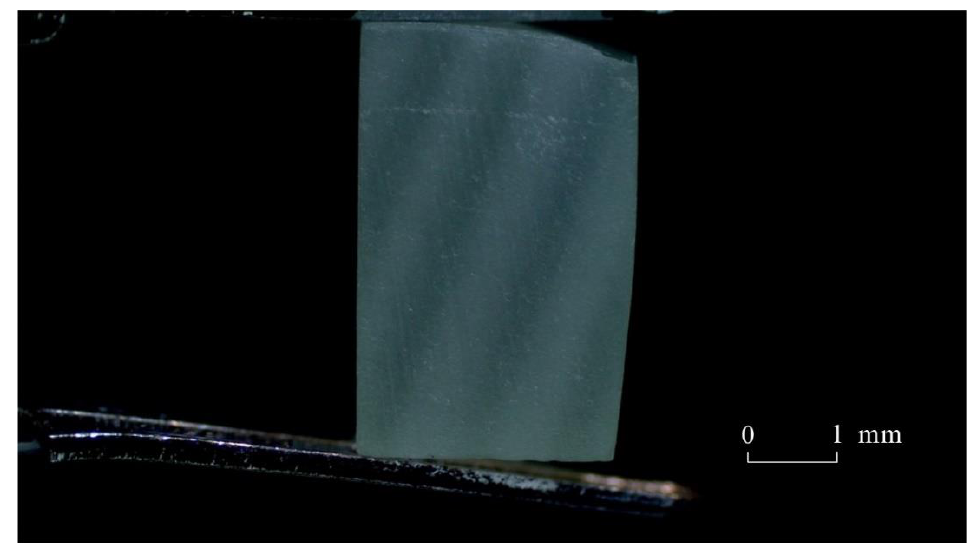
Figure 2. Rectangular slice through cabochon specimen S 1 of Lvwen stone.